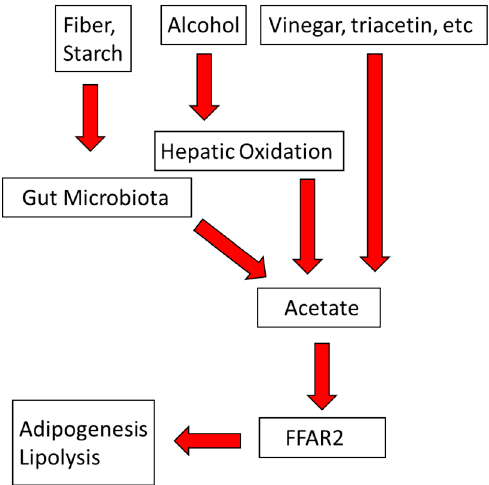
Figure 5. Schematic model of the conversion of dietary components into acetate, the bioactive ligand for free fatty acid receptor 2 (FFAR2).